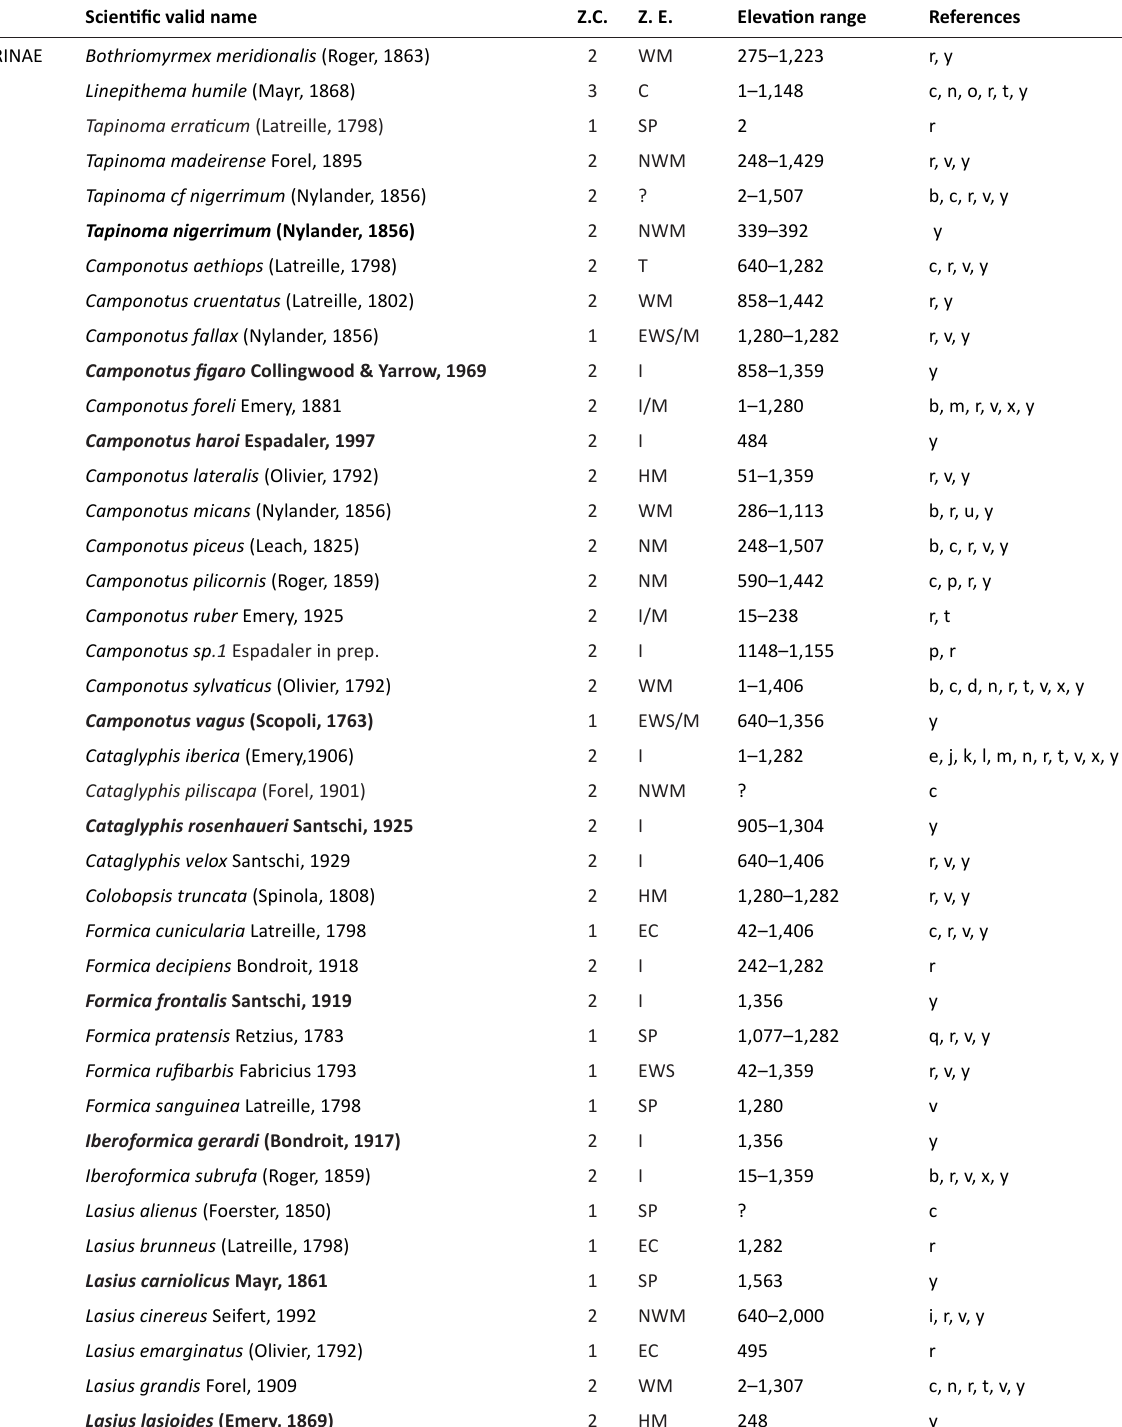
Table 1. Checklist of the ant species of the Segura River Basin. The list is arranged alphabetically by subfamily, genus and species. Species names in bold characters refer to species recorded for the first time in this area. Zoogeographical classes (ZC) and Zoogeographical elements (ZE) abbreviations: 1 = mixed and deciduous forest zone, 2 = Mediterranean zone, 3 = Cosmopolitan, CSE = Central and Southern European, CSE/M = Central and Southern European/Maghrebian, C = Cosmopolitan, EC = Euro-Caucasian, EC/M = Euro-Caucasian/Maghrebian, EWS = Euro-West Siberian, EWS/M = Euro-West-Siberian/Maghrebian, HM = Holomediterranean, I = Iberian, I/M = Iberian/ Maghrebian, NM = North-Mediterranean, NWM = North-West Mediterranean, SP = South-Palearctic, T = Tethyan, U = Unknown, WM = West-Mediterranean, ? = zoogeographical element questionable. Elevation range units: masl. Bibliographic references are as follows: a = Emery 1924, b = Santschi 1932, c= Collingwood & Yarrow 1969, d = Martínez & Espadaler 1986, e = Cerdá 1988, f = Seifert 1988, g = López et al. 1990, h = López, 1991, i = Seifert, 1992, j = Haro et al. 1995, k = Dahbi et al. 1996, l = Espadaler 1997c, m = Martínez et al. 1997, n = Martínez et al. 2002, o = Morcillo et al. 2006, p = Espadaler et al. 2007, q = Tinaut et al. 2011, r = Catarineu & Tinaut 2012, s = Martínez et al. 2012, t = Arcos et al. 2013, u = Del Campo et al. 2014, v = Asociación Ibérica de Mirmecología 2016, x = Catarineu et al. 2017, y = present paper. For locations, see Table